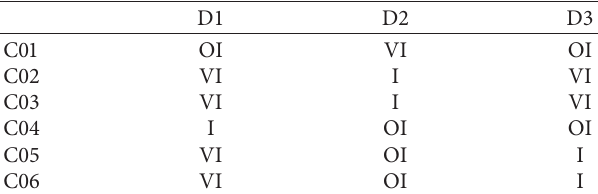
Table 4: Linguistic terms of experts’ viewpoint in social criteria.